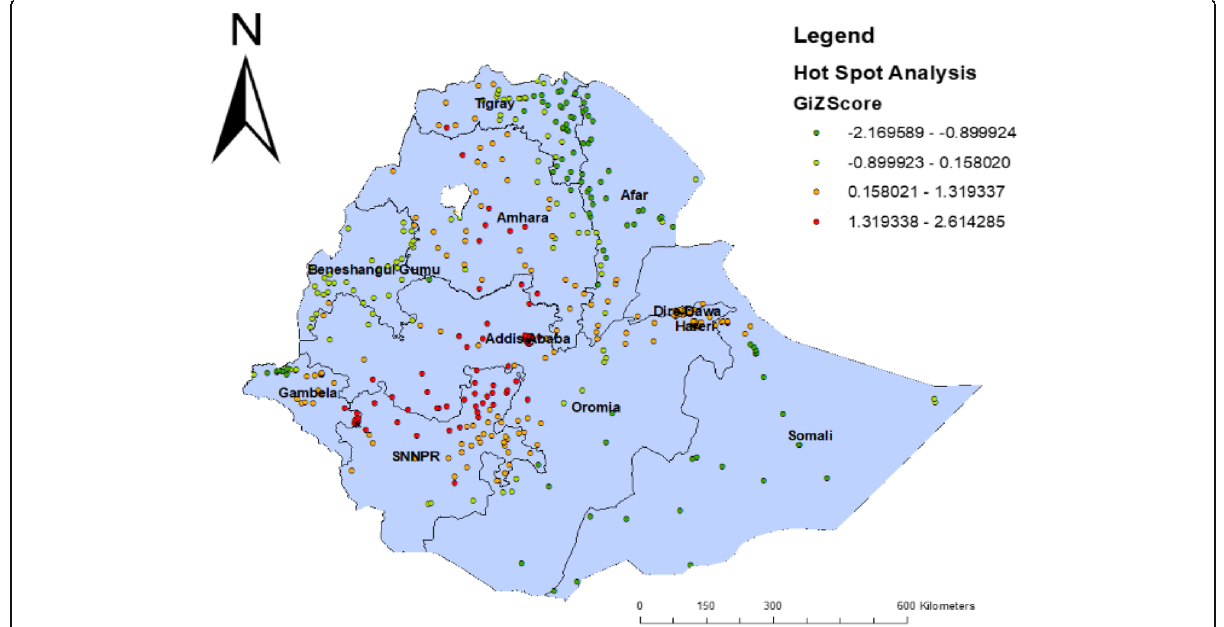
Fig. 3 Hot spot analysis of childhood diarrheal disease among under 5 years of age in Ethiopia, EDHS